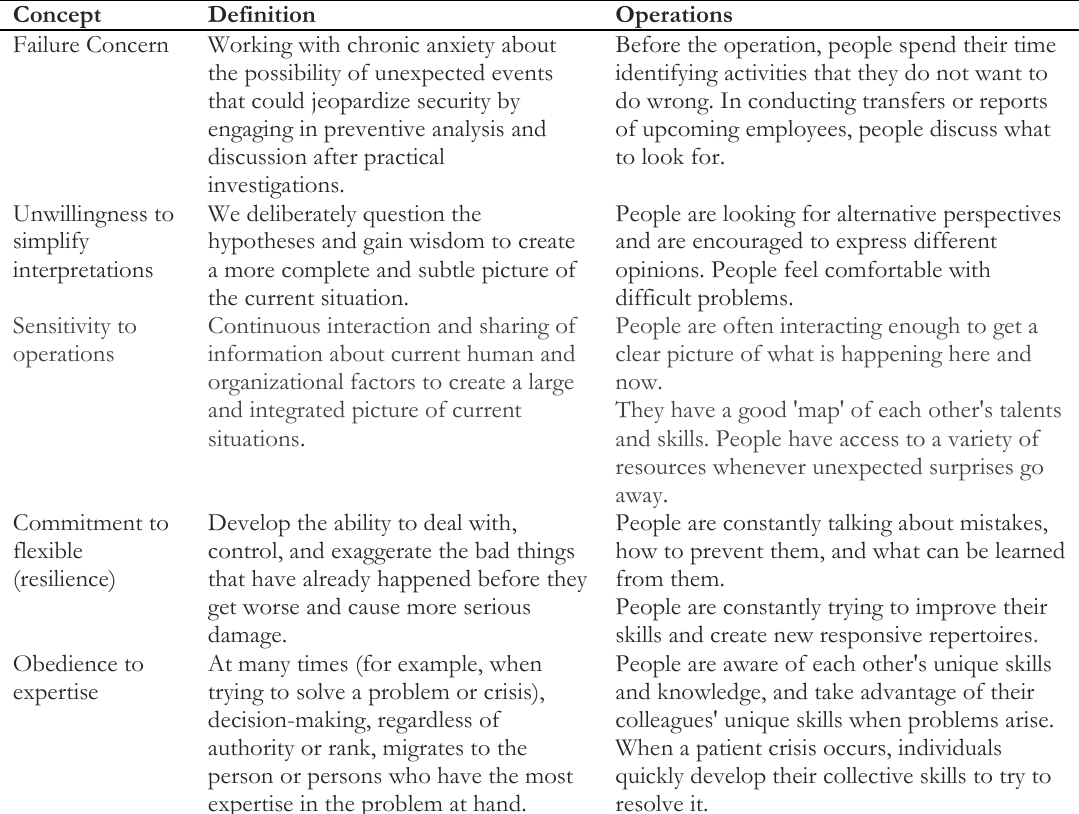
Table 1. High-reliability organization chart and illustrated